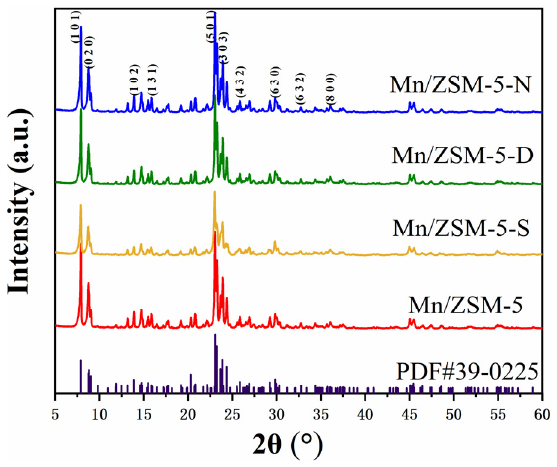
Figure 4. XRD patterns of Mn/ZSM ‐ 5 and modified catalysts.